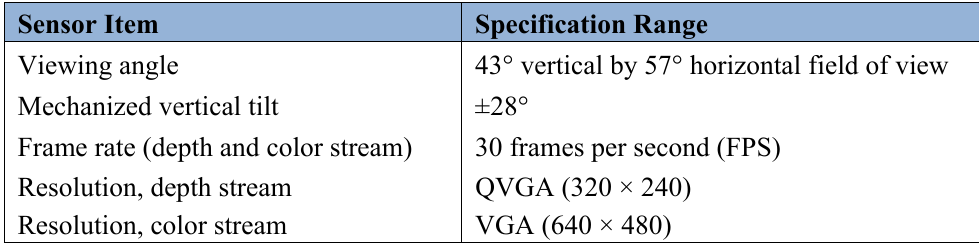
Table 3. Kinect TM principal features for capturing image video and